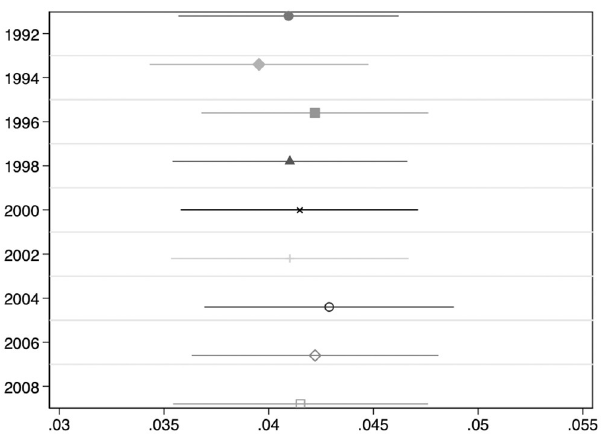
Fig 2. Association between BMI polygenic scores and Log(BMI) along the life-cycle. HRS Original Cohort . This Figure summarizes the results of estimating Eq 2 on the balanced sample of 3,181 HRS Original cohort members described in Table 1. The dependent variable is Log(BMI). OLS coefficient estimates of β 1 as well as their associated 95% confidence intervals are depicted. All regressions include a female dummy, age, age squared, and the first 10 principal components of the full matrix of genetic data. Standard errors are clustered at the household